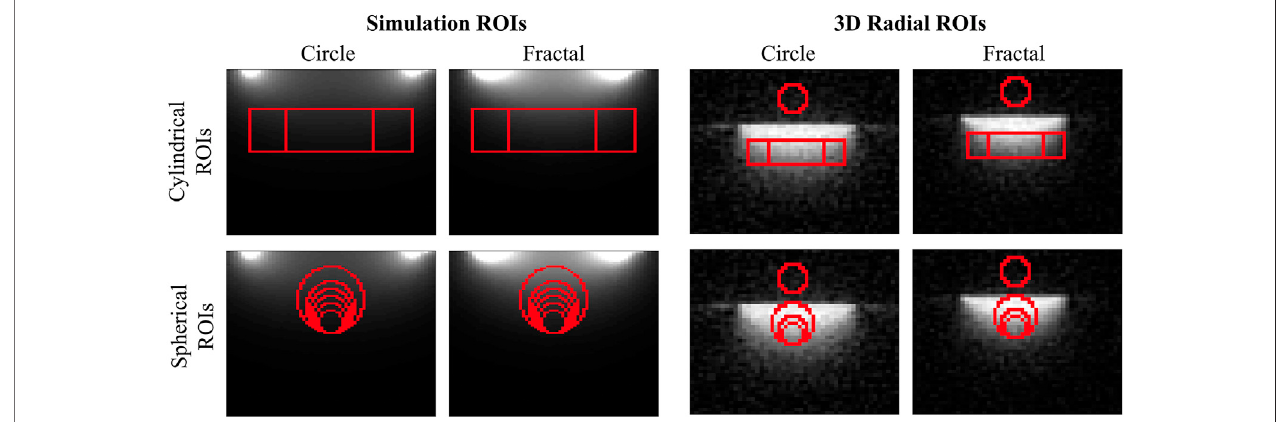
FIGURE 3 | The ROIs used for the homogeneity measurements of the simulated fi elds and the 3D radial volume data, as well as the SNR calculations from the 3D radial data of both the circular and fractal coils. The cylindrical ROIs are of radius 25 mm and ∼ 45 mm and are used to represent the coil ’ s optimal sensitivity region betweenr/2andrdeepintothephantom[4].ThesimulationsalsousedsixsphericalROIsofradii6,8,10,12,14,and18 mm,whereasthemeasured3Dradialdataused only three spherical ROIsofradii 9,12.5, and 18.75 mm. ThenoiseROIfor SNRcalculationsusing themeasured dataisshown asthesphericalROIabove the coil plane for the 3D radial